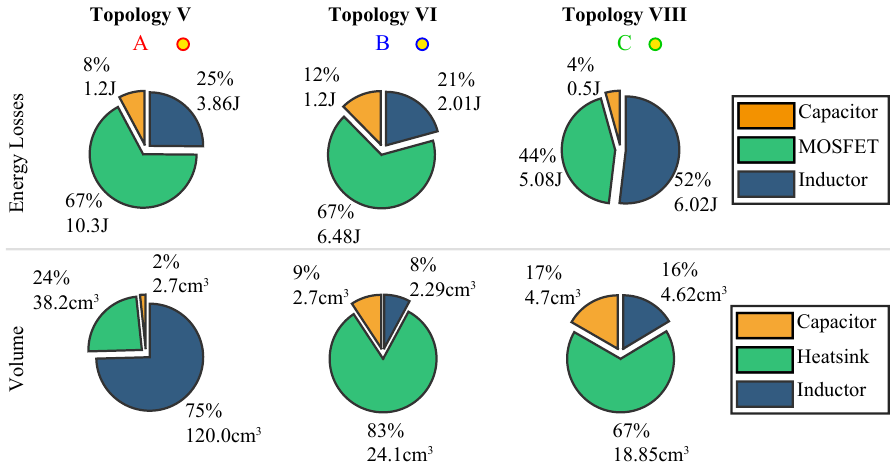
Figure 17. Estimated energy losses and Volume breakdown for the SCIC of topologies V, VI, VIII.